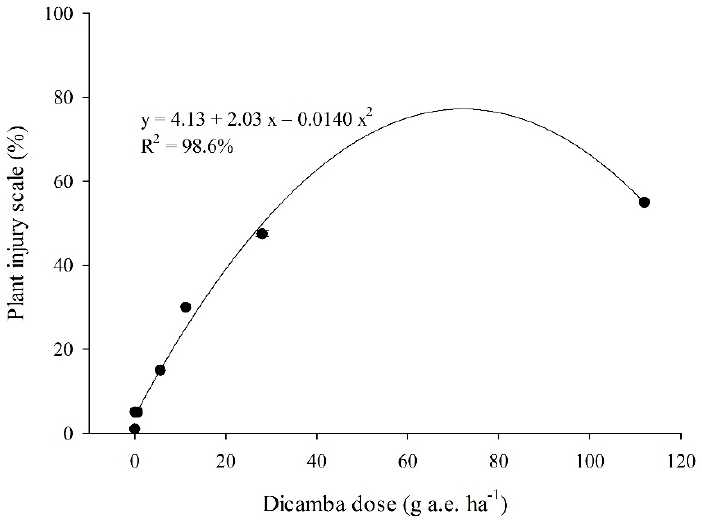
Figure 4. Soybean injury scale for different doses of dicamba at 5 days after application of the dicamba doses (0, 0.056, 0.56, 5.6, 11.2, 28, 112 g.e. ha − 1 ). Error bars in each point denote standard